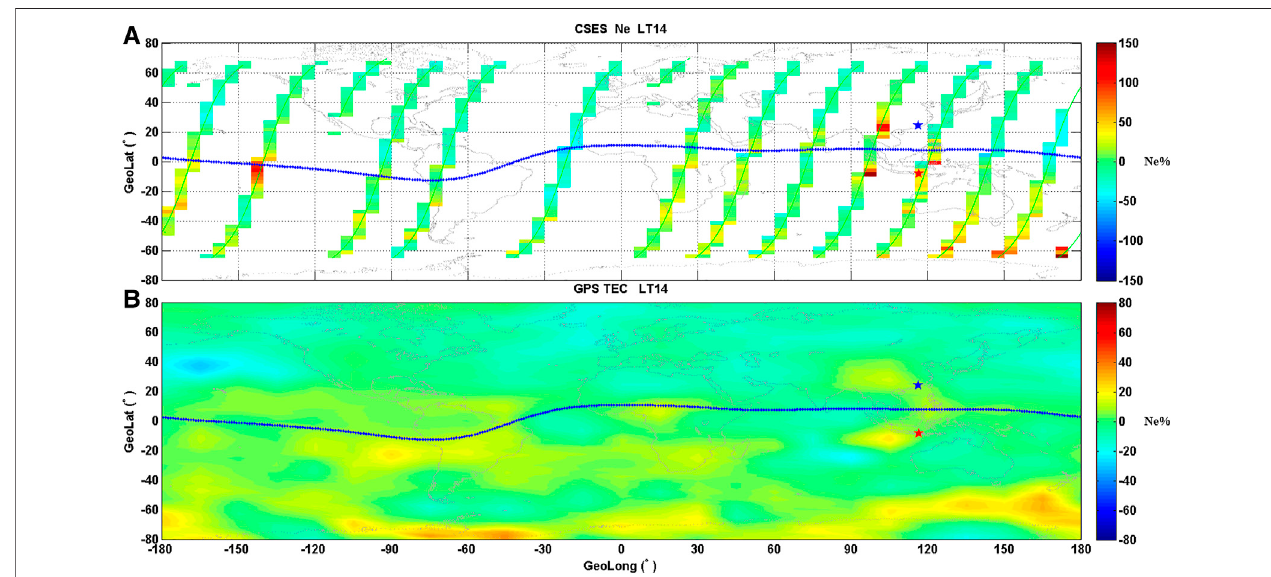
FIGURE 6 | Relative change of CSES Ne (A) and GIM TEC (B) in the daytime on 4 August 2018. Blue line represents magnetic equator. Red star shows the epicenter and blue one indicates its conjugate point.